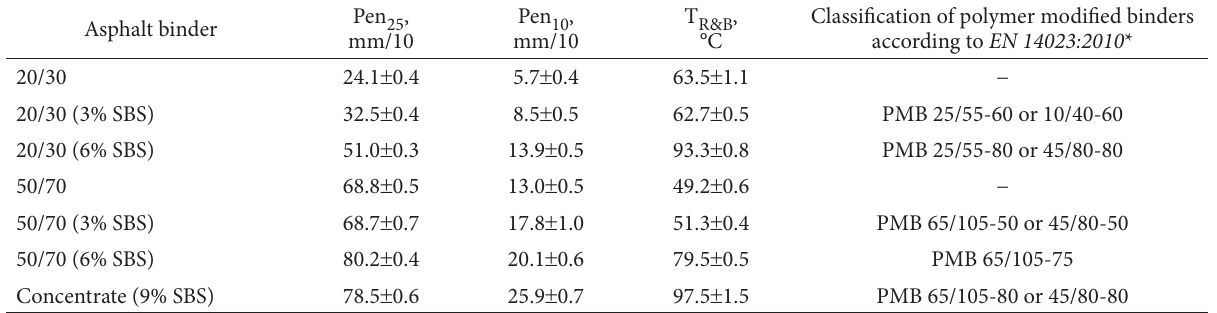
Table 2. Results of the determination of basic properties of the tested asphalt binders Asphalt